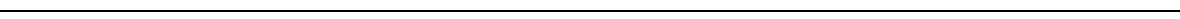
Fig. 5 Restoration of axonal transport and of ER-mitochondrial overlay by HDAC6 inhibition. a Immunostaining for ER (using mouse PDI antibody) and mitochondria (using rabbit TOM-20 antibody) of motor neurons derived from iPSC from patients carrying the P525L mutation and healthy controls before and after an overnight treatment with ACY-738 (1 μ M). The separate views show co-localized pixels in the cell body and neurites. Scale bar = 5 µ m. b Quanti fi cation of the proportion of ER-merged regions and mitochondrial-merged regions relative to the total mitochondrial staining. Data were analyzed by determining the Pearson ’ s correlation coef fi cient using ImageJ ( n = 20, mean ± SEM, one-way ANOVA with post-hoc Tukey ’ s test, *, *** P values of 0.05 and 0.001). c Phosphatidylcholine (PC) level in culture media from motor neuron. Media were taken for ELISA after 2 days on the culture at the fourth week after the start of differentiation. A decrease was observed in patient-derived motor neurons. Representative experiment is shown (mean of technical duplicates ± SD). d Quanti fi cation of stationary mitochondria, moving mitochondria, and ratio between moving to total mitochondria normalized to a neurite length of 100 µ m in motor neurons derived from patient and healthy control iPSC lines at the fourth week after plating with or without an overnight treatment with ACY-738 ( n = 18, n = 16, n = 15, n = 18, n = 15, n = 13, n = 17, n = 13 for Ctr1 + DMSO, Ctr1 + ACY-738, Ctr2 + DMSO, Ctr2 + ACY-738, R521H + DMSO, R521H + ACY-738, P525L + DMSO, P525L + ACY-738, respectively, mean ± SEM, one-way ANOVA with post-hoc Tukey ’ s test; *, ** P values of 0.05 and 0.01, respectively). e Quanti fi cation of stationary ER vesicles, moving ER vesicles, and ratio between moving to total vesicles normalized to a neurite length of 100 µ m in motor neurons derived from patient and healthy control iPSC lines at the fourth week after plating with or without an overnight treatment with ACY-738 ( n = 10, n = 19, n = 11, n = 18, n = 12, n = 12, n = 11, n = 16 for Ctr1 + DMSO, Ctr1 + ACY-738, Ctr2 + DMSO, Ctr2 + ACY- 738, R521H + DMSO, R521H + ACY-738, P525L+ DMSO, P525L+ ACY-738, respectively, mean ± SEM, one-way ANOVA with post-hoc Tukey ’ s test; *, **, *** P values of 0.05, 0.01, and 0.001,